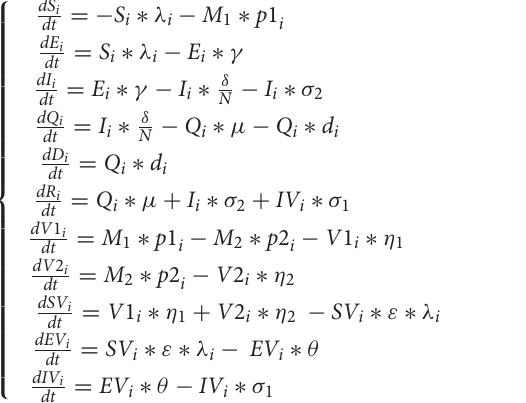
31–40, 41–50, 51–60, and 60 + years, respectively. The